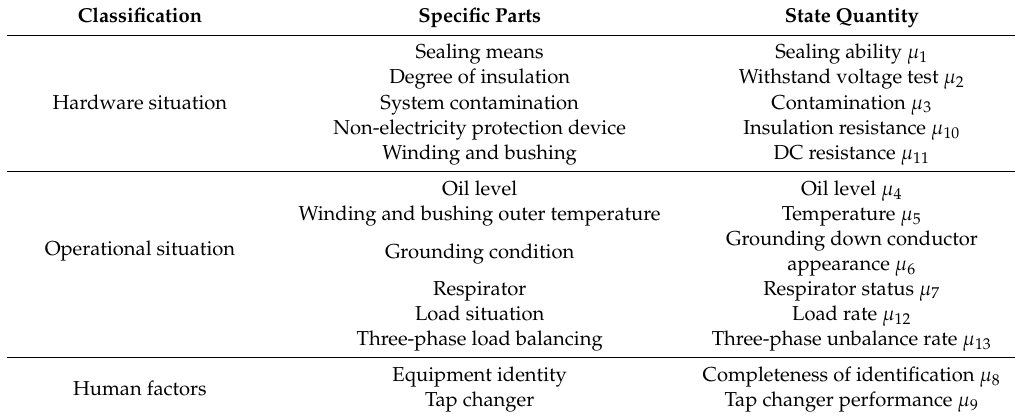
Table 2. Selection and classification of distribution transformer key state